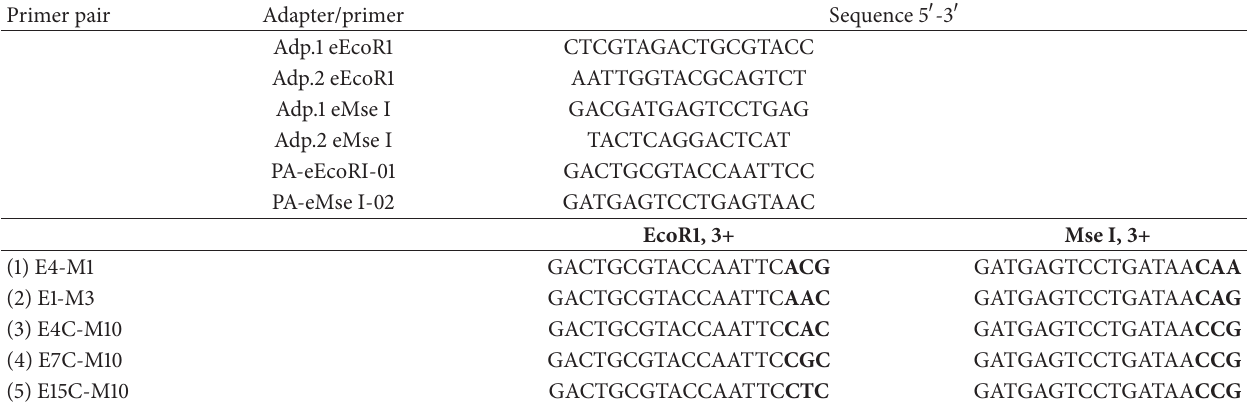
Table 1: Set of AFLP primer and adaptor pairs used for the ligation: preselective and selective amplification of cDNA (in bold: selective nucleotides, PA: preselective primers for